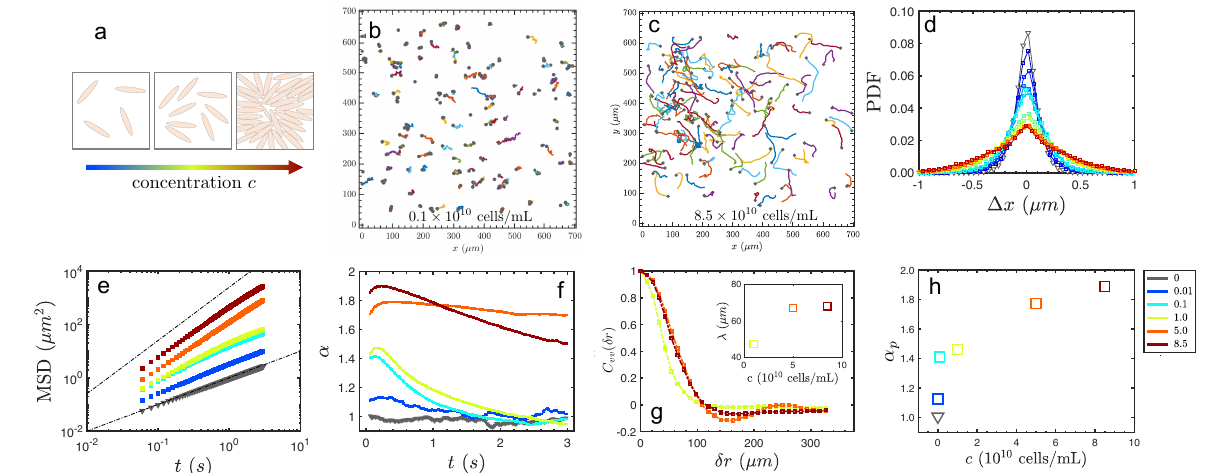
Figure 4. ( a ): Sketch of increasing bacterial population. ( b , c ): Typical trajectories of tracer particles in bacterial suspension at different number densities. ( d – f ): PDF of ∆ x at ∆ t = 1/50 s, MSD= < ∆ x 2 ( t ) > of tracer versus lag time t , and Slope of MSD in bacteria suspension with varying number density (in color). ( g ): Correlation and characteristic length (inset) of the velocity field at high number density of bacteria. ( h ): Apparent superdiffusion exponent α p vs. number density, calculated from the slope of time